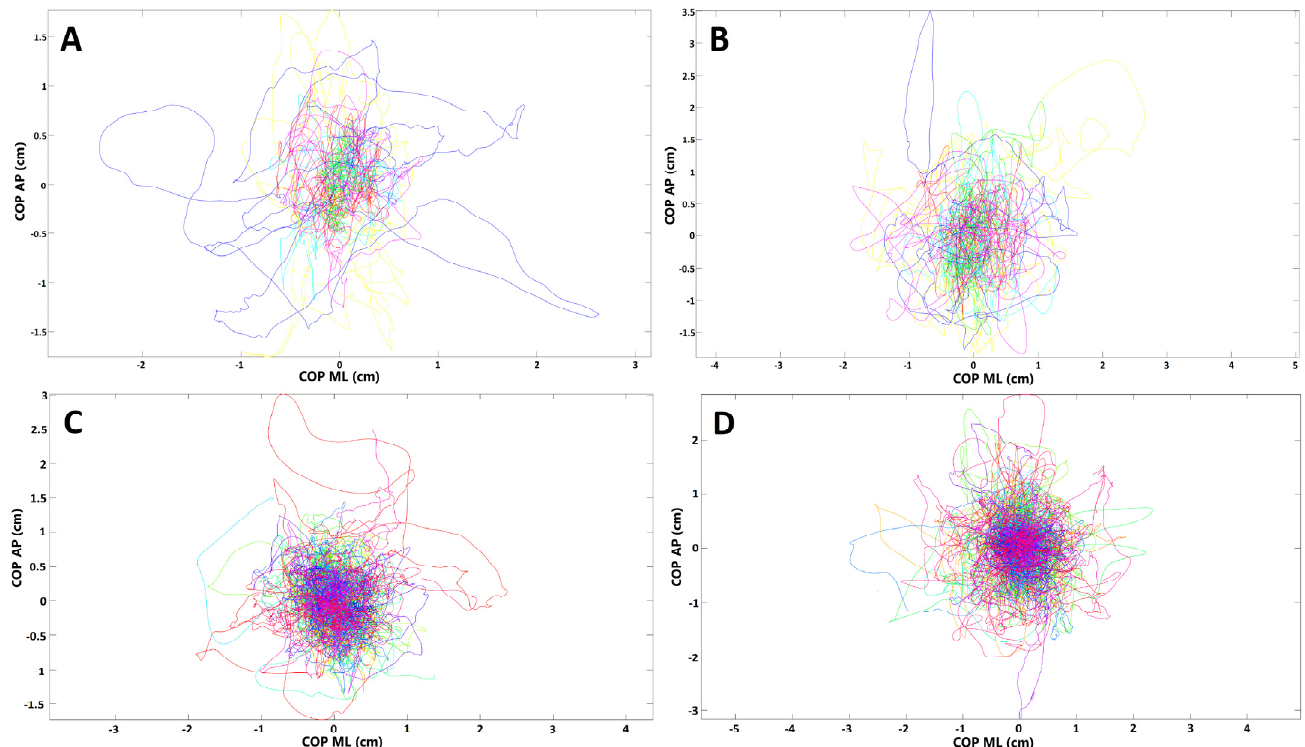
Figure 3. Presentation of COP (center of pressure) migrations in ( A , B ) subjects who had respiratory distress during COVID–19; ( C , D ) subjects without such ailments (each line represents single participant; AP, anterior–posterior (frontal) plane; ML, medial–lateral (sagittal) plane). ( A , C ) Trials with eyes open; ( B , D ) trials with eyes closed.